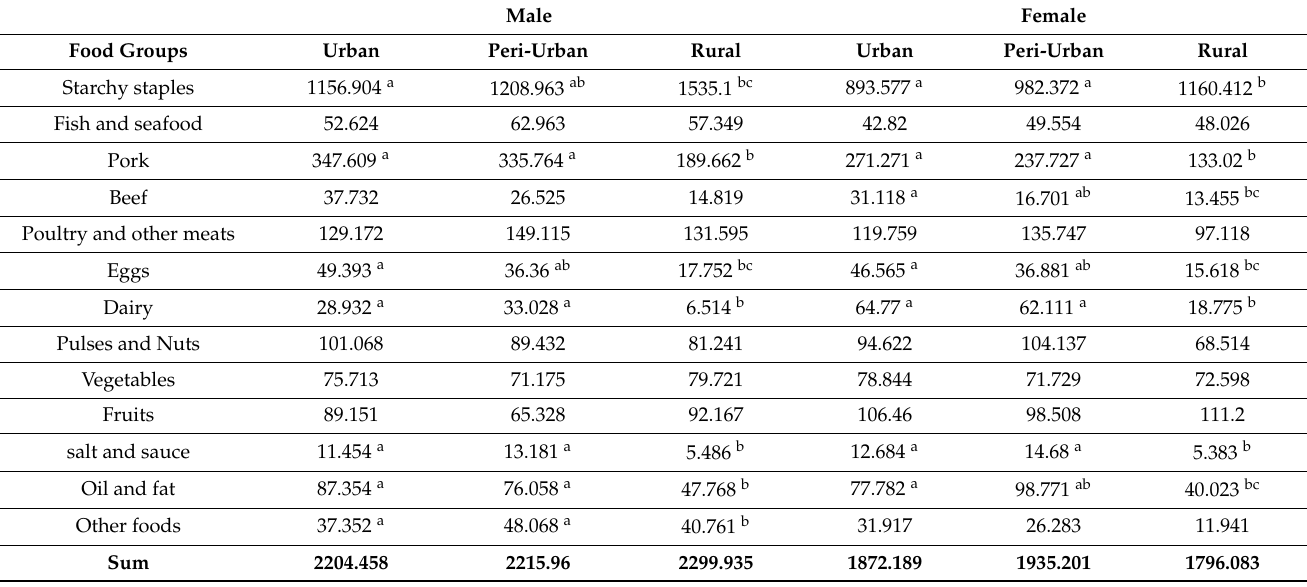
Table A3. Usual individual daily calorie intake by food group, gender, and district. Male Female